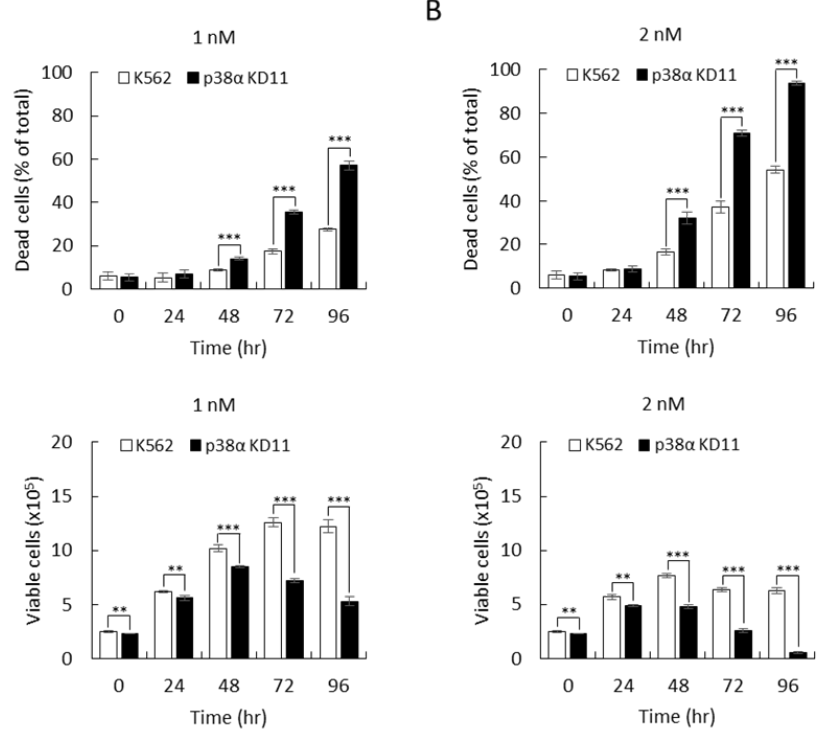
Figure 5. The cytotoxic effect of dasatinib was also enhanced upon p38 α knockdown. The K562 parental and p38 α -knockdown (KD11) cells were treated with 1 ( A ) or 2 nM ( B ) of the second-generation TKI dasatinib. The viability of cells was examined by trypan blue exclusion. Knockdown of p38 α greatly enhanced the therapeutic efficacy of dasatinib. All results shown are representative of three independent experiments. Viable and dead cell numbers are presented as the mean ± SE of three repeats. ** p < 0.01, and *** p < 0.005.